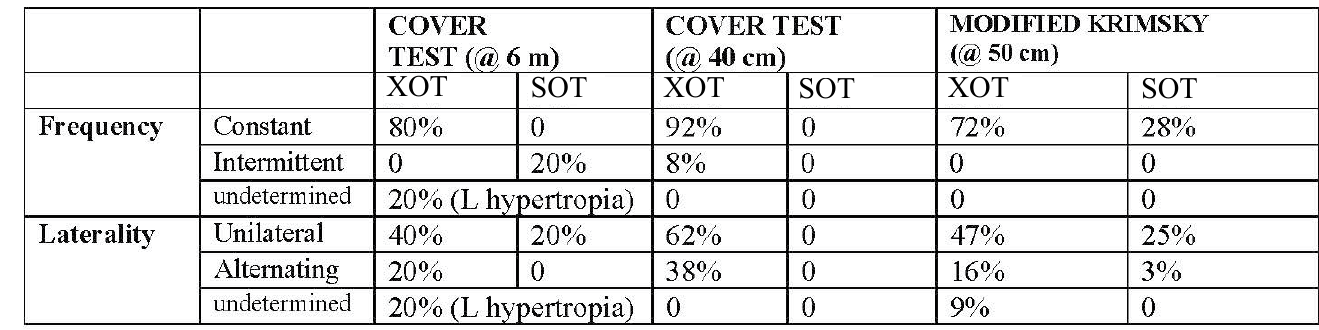
Table 3: Frequency and laterality of the strabismus detected using three tests in 50 schizophrenics based at DMH, Kwazulu-Natal, South